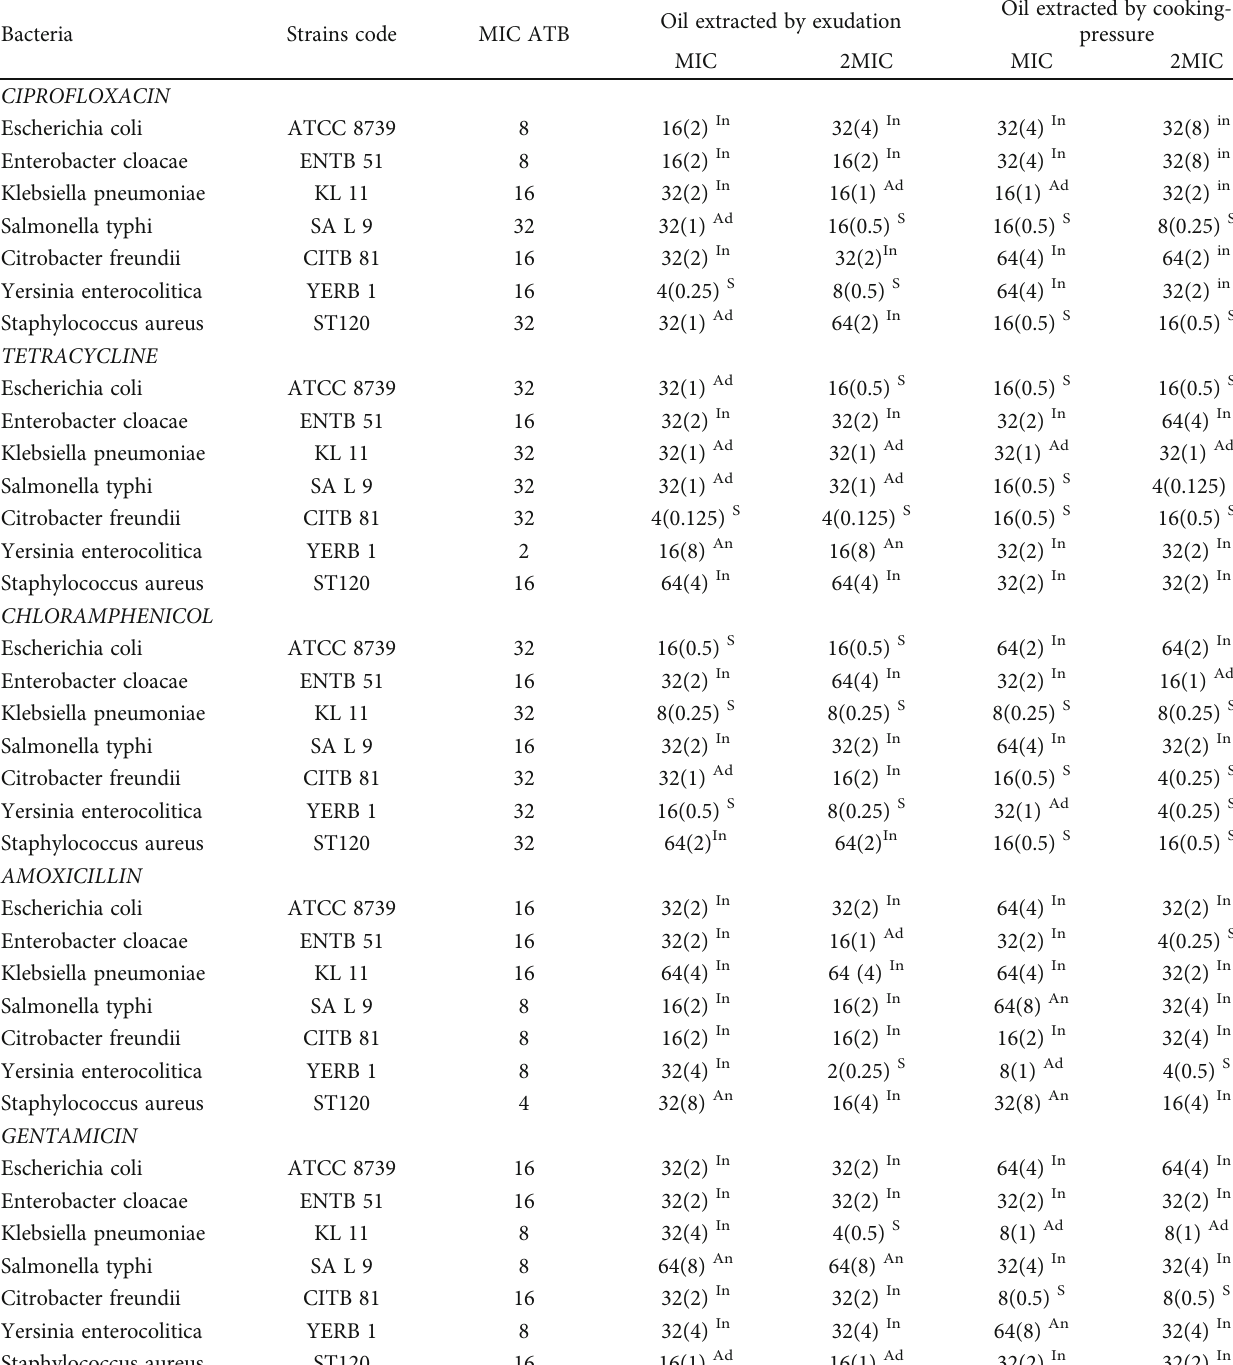
Oil extracted by Oil extracted by exudation